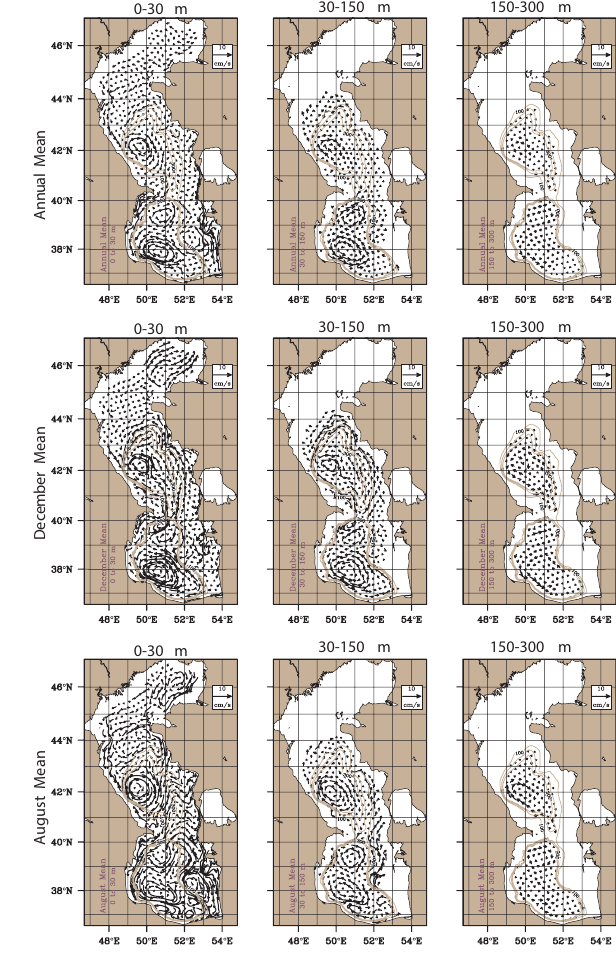
Figure 3. Model-derived mean currents (cm s − 1 ) from a control run averaged over depth intervals of 0–30m, 30–150m and 150–300m. Contour lines shows the 100, 200 and 300m bathymetry contours. Upper row: annual; middle row: December; lower row: